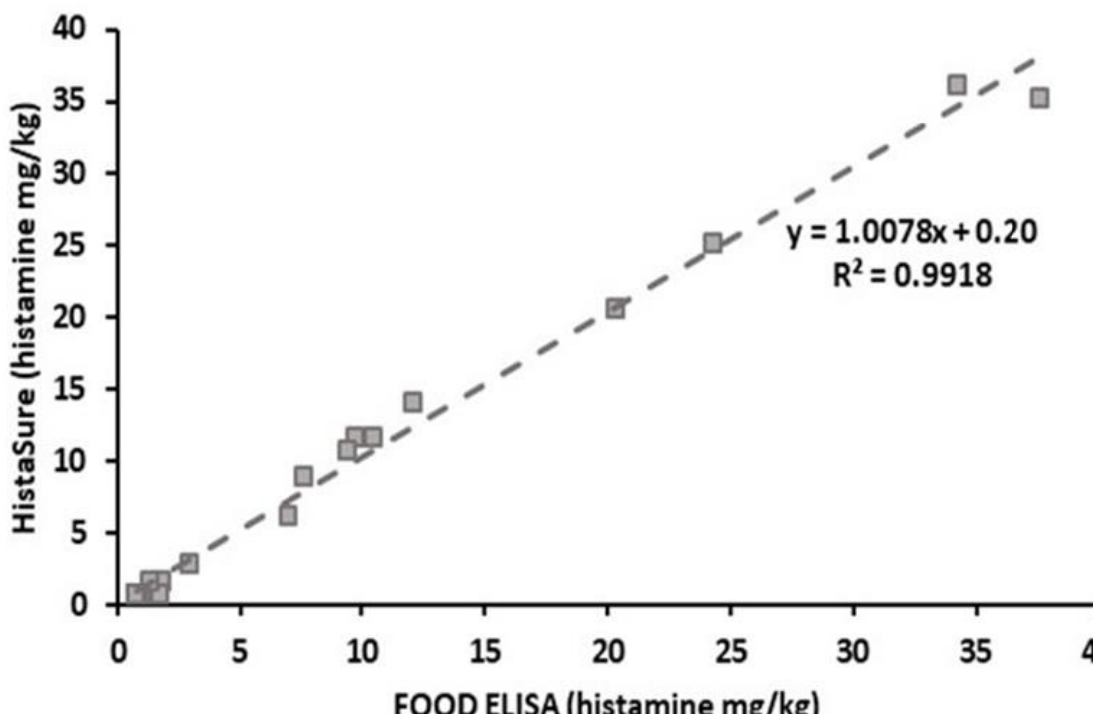
Figure 3. Correlation results of Food ELISA test kit and HistaSure ELISA (Fast Track) in determining histamine in various fish products.